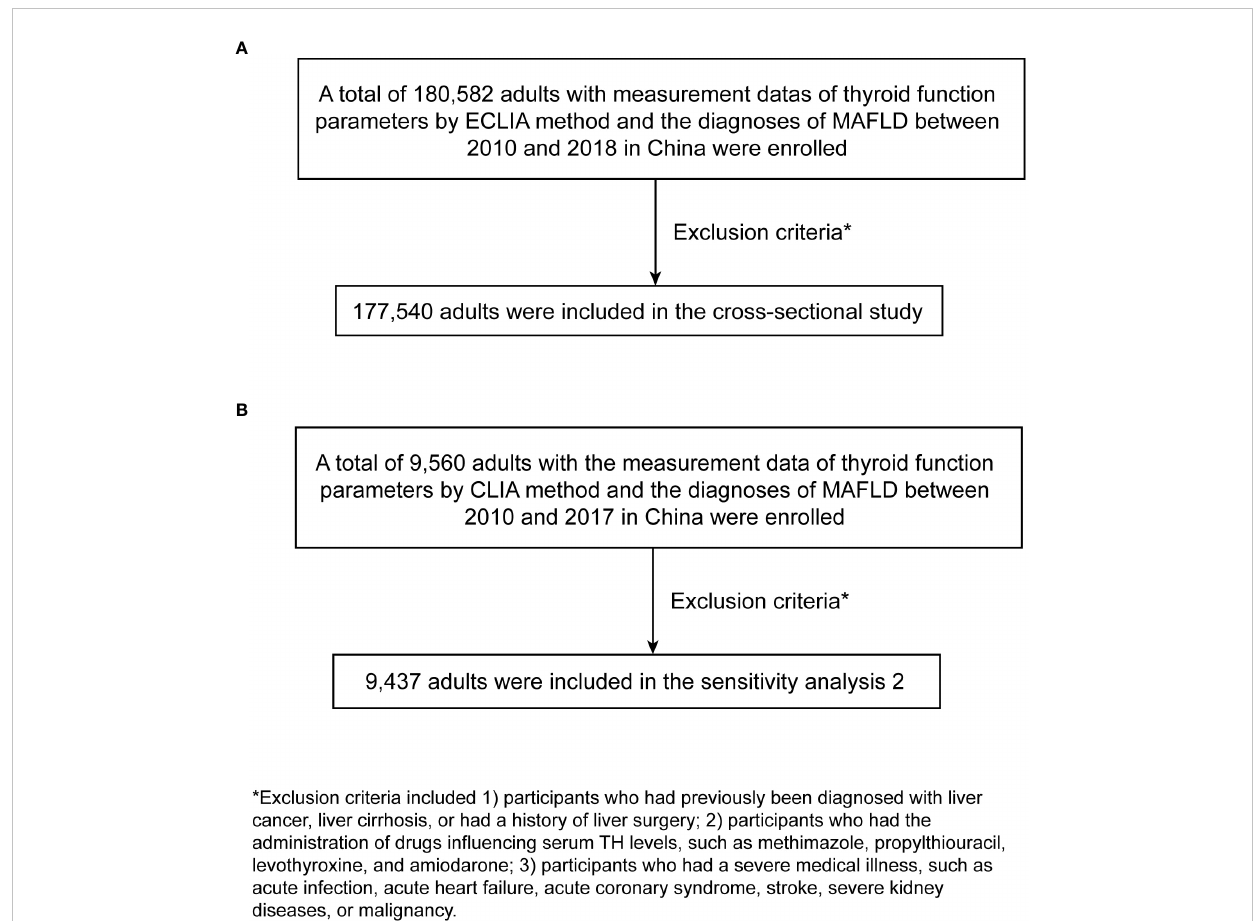
FIGURE 1 The fl ow chart of participant selection. (A) main study. (B) sensitivity analysis 2. ECLIA, electrochemiluminescence immunoassay; MAFLD, metabolic dysfunction-associated fatty liver disease; CLIA, chemiluminescence